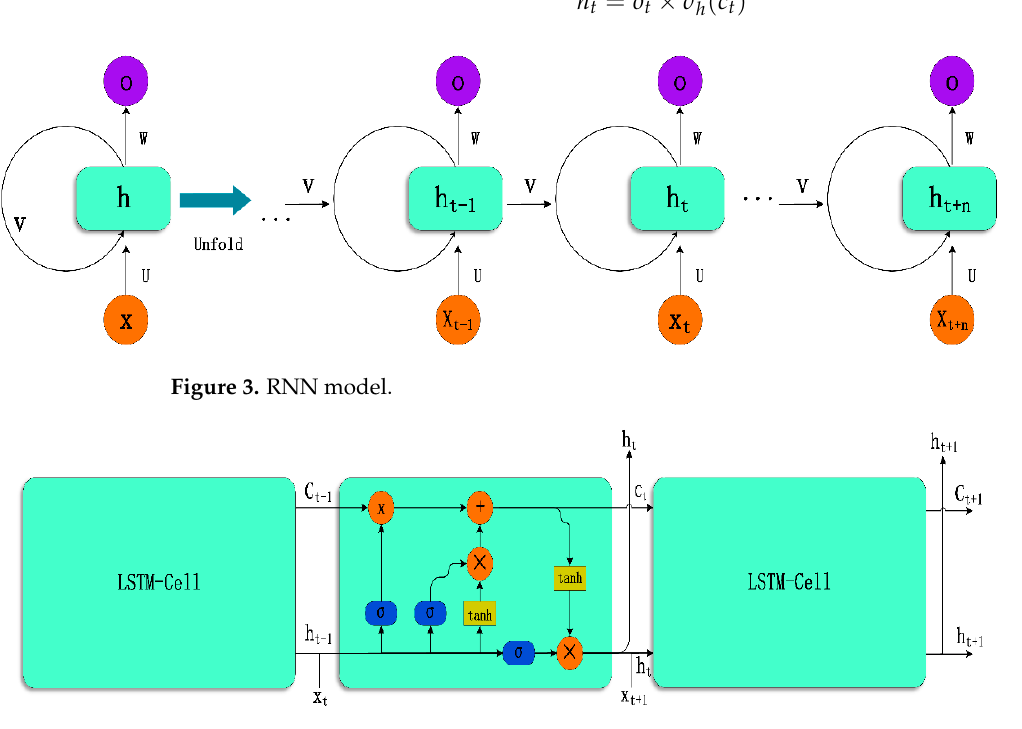
Figure 4. LSTM model.